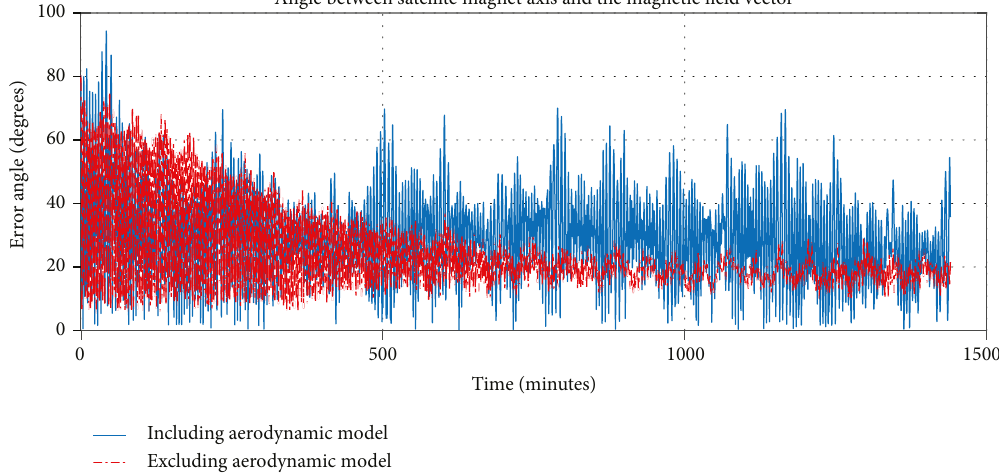
Figure 11: Magnetic tracking error angle for the cases excluding (Figure 6) and including (Figure 10) aerodynamic modelling. Neglecting aerodynamics gives falsely optimistic results.